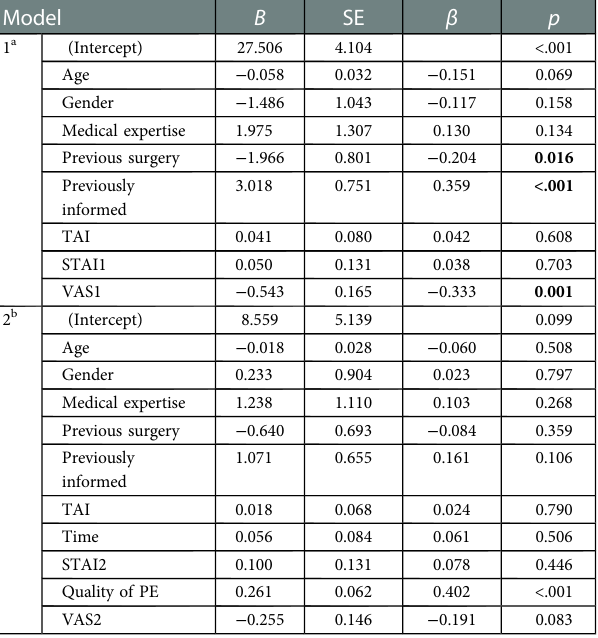
TABLE 3 Analysis of procedural knowledge before and after the PE measured with questionnaire at timepoint 1 and